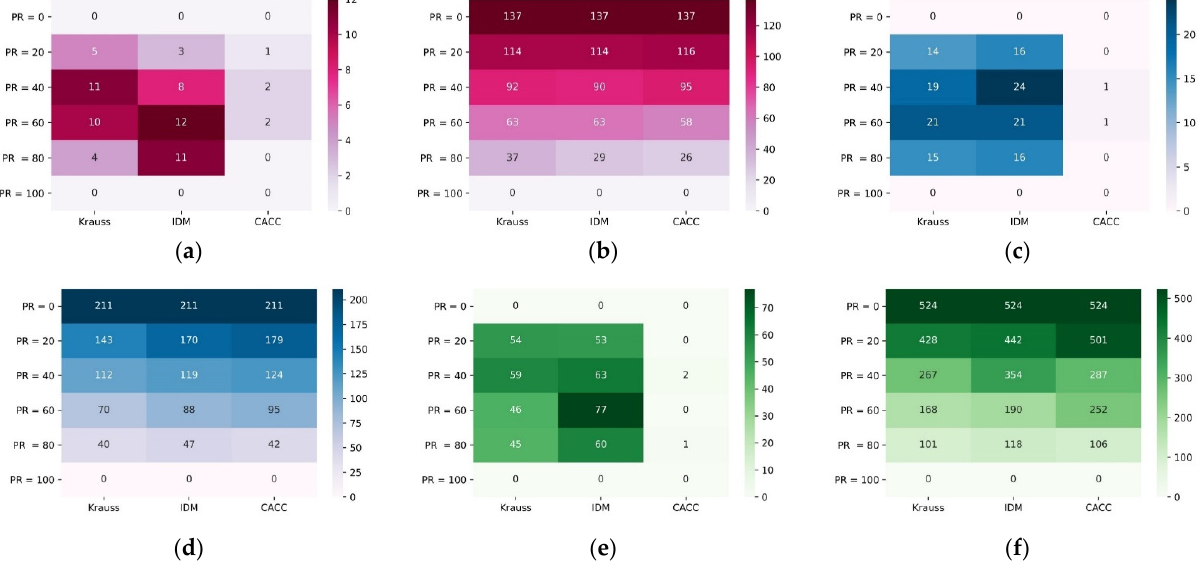
Figure 9. Number of conflicts based on different demands and different car-following